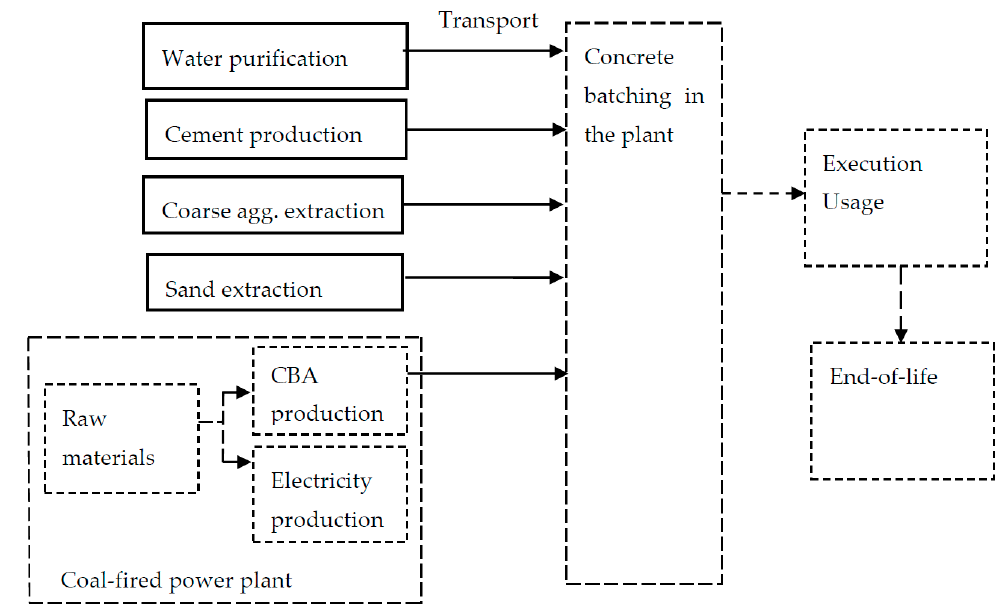
Figure 1. Cradle-to-gate life-cycle assessments (LCA): Studied concrete system boundaries (plain line—included processes; dashed line—excluded